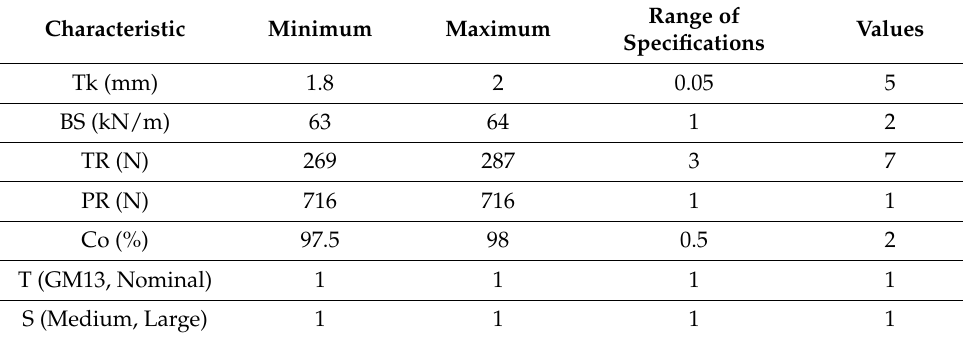
Table 4. Suitable ranges of geomembrane characteristics.